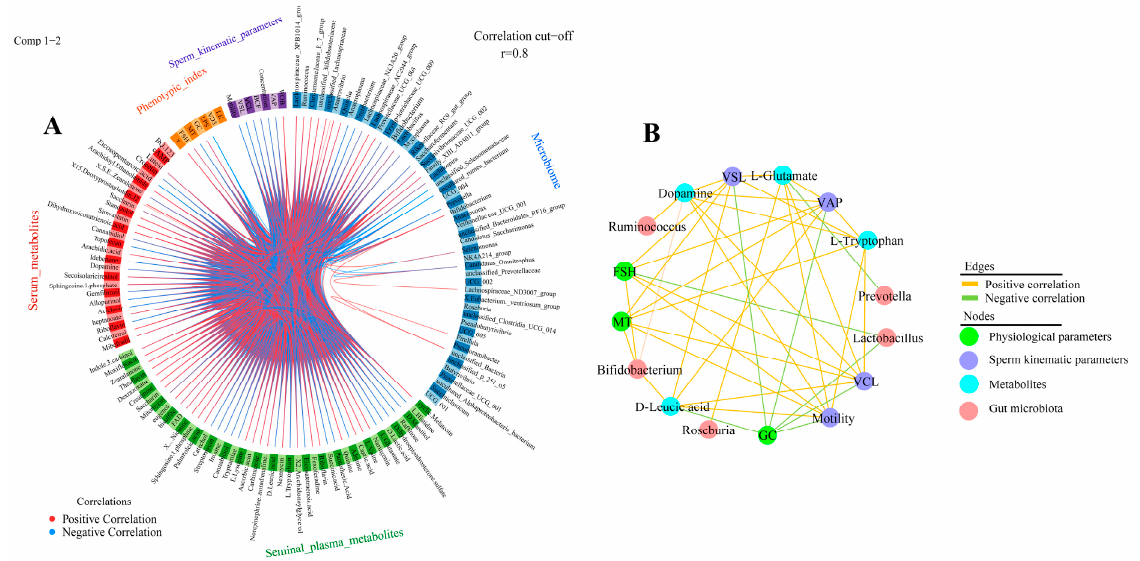
Figure 7. Microbiome and metabolome correlation analysis ( A ) Circos plot showing correlations between microbiome, serum metabolome, seminal plasma metabolome group, physiological parameters, and sperm kinematic parameters, with positive correlations indicated by red lines and negative correlations by blue lines. Only results for R > 0.8 are shown. ( B ) Based on DIABLO analysis results, Cytoscape shows correlations between key microbial genera, metabolites, physiological parameters, and sperm motility parameters .